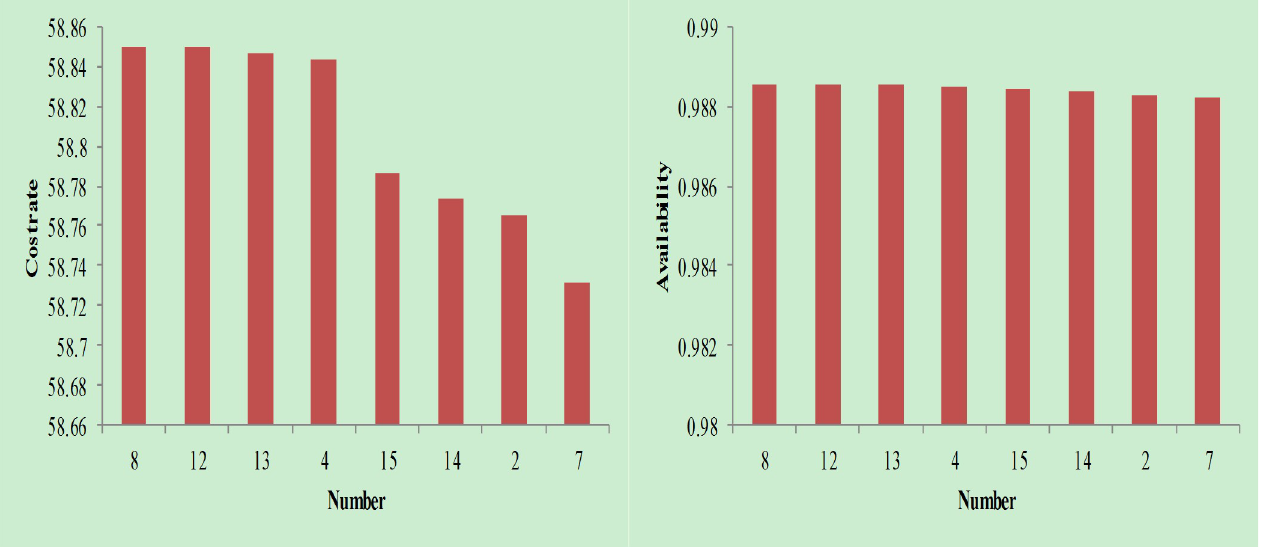
Fig 9. Cost rate and availability analysis when follow-up maintenance cost and downtime are